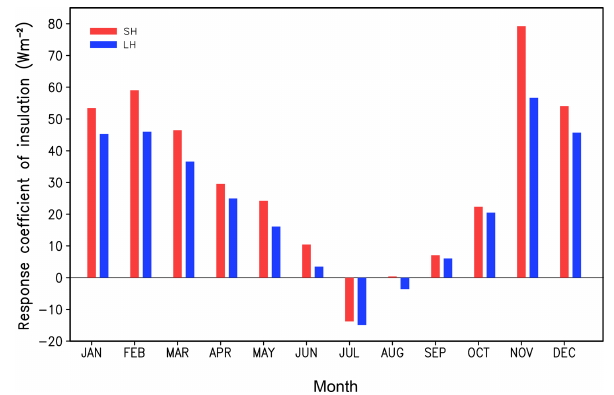
Figure 10. The monthly response coefficients (Wm − 2 ) of sensible and latent heat fluxes to the insulation effect of sea